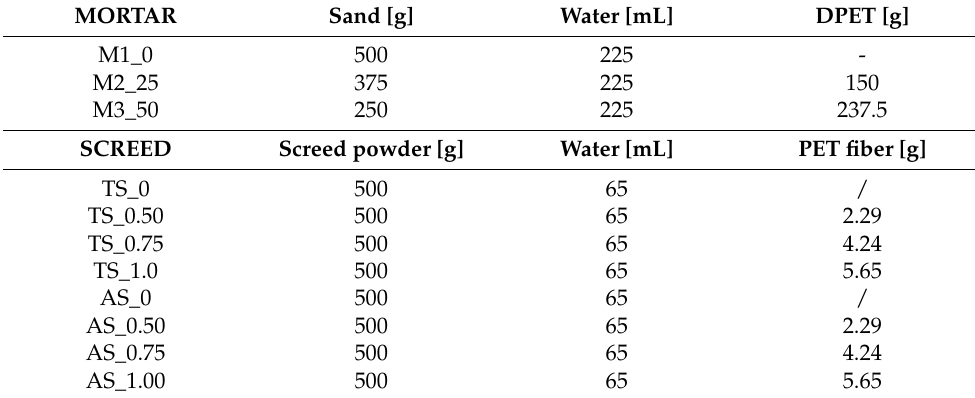
Table 2. Mix design of the tested mortars and screeds.